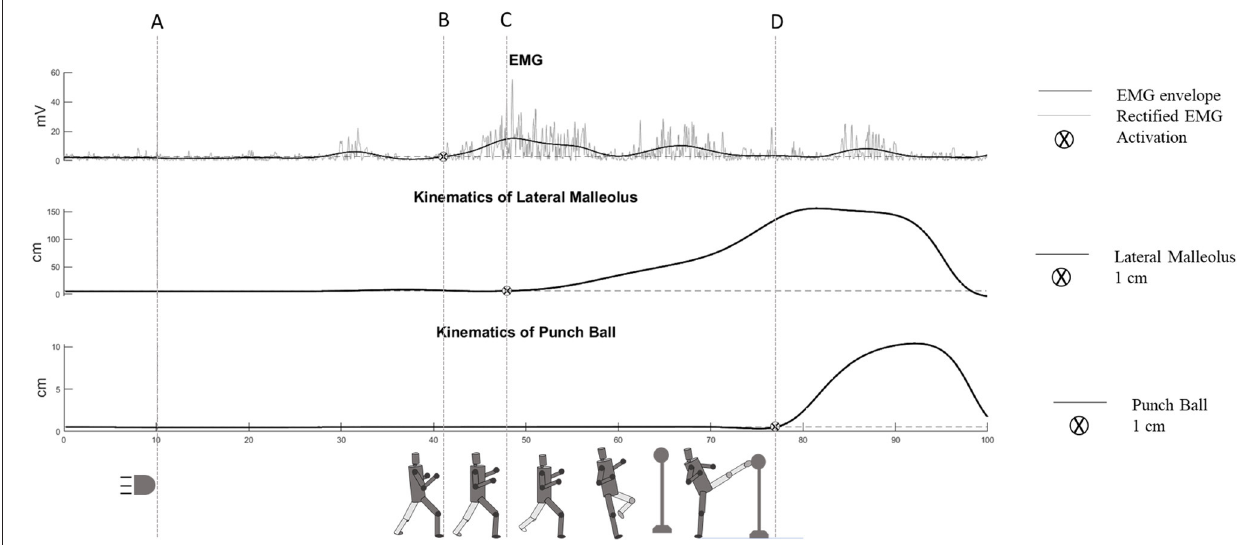
FIGURE 2 | Measurement of the parameters associated with the neuromuscular and motor performance of the roundhouse kick from a representative participant. The dot line (A) represents the visual stimulus; (B) represents the electromyography activation onset of the rectus femoris muscle; (C) represents the kinematics of the lateral malleolus onset (movement of 1cm of the lateral malleolus marker), and (D) represents the target onset (movement of 1cm of the punch ball